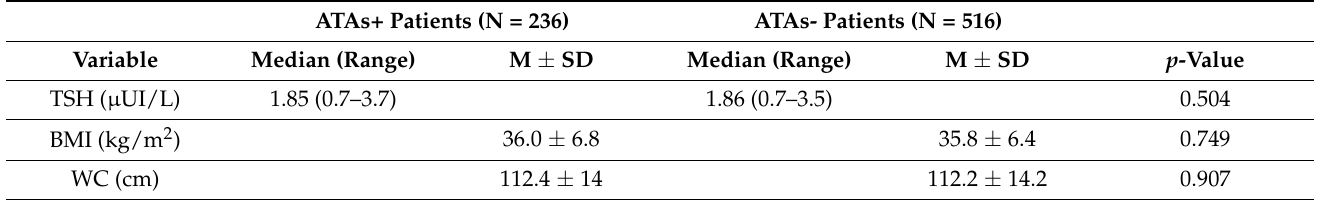
Table 2. TSH serum levels, BMI, and WC values according to ATAs status in the whole sample. ATAs+ Patients (N = 236) ATAs- Patients (N =